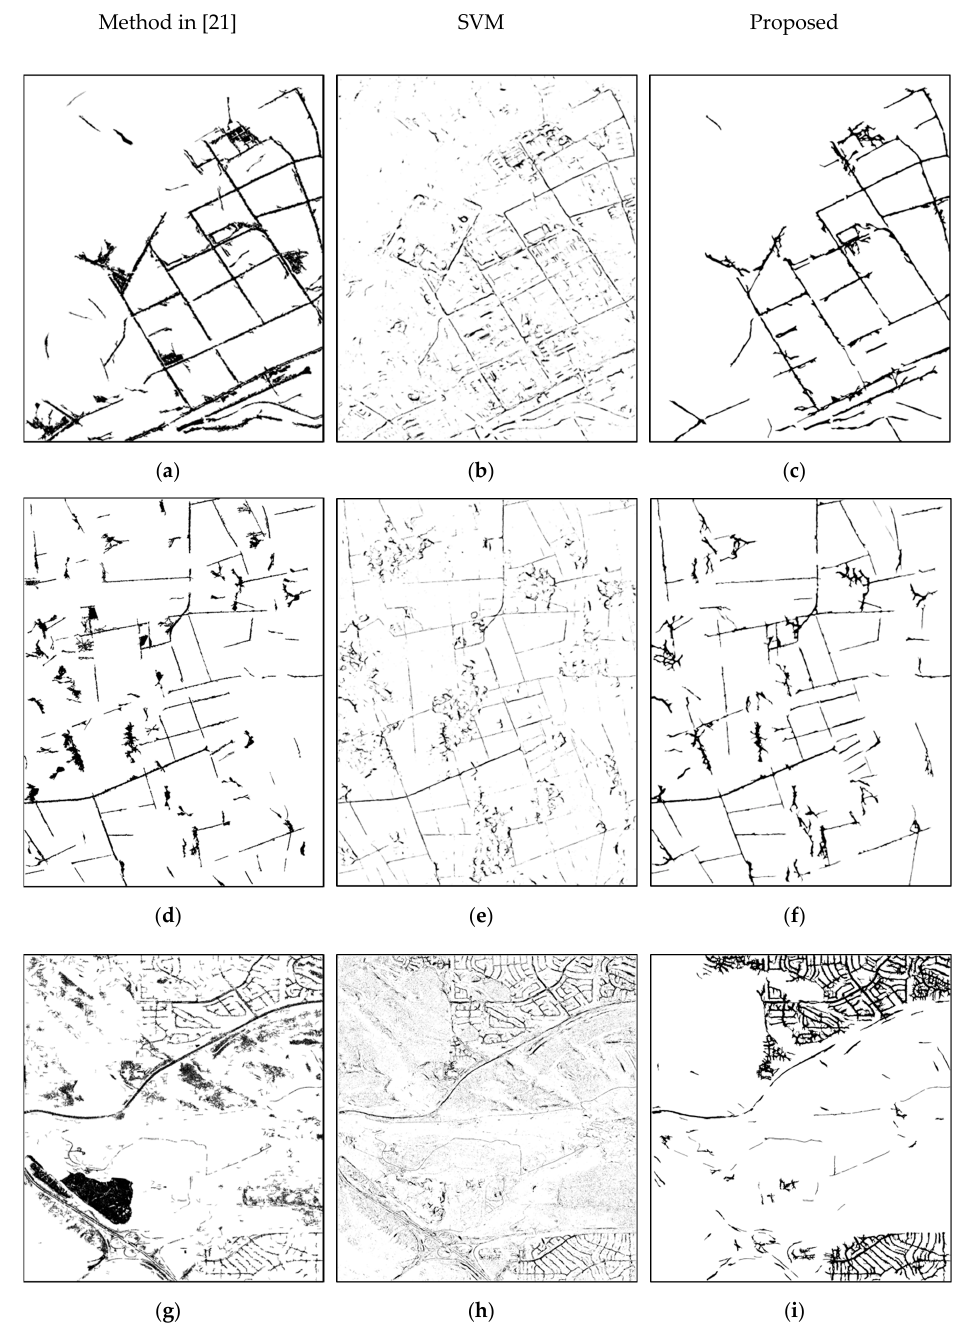
Figure 10. Segmentation results of road candidates using method in [21], SVM, and proposed approach: ( a–c ) study site 1; ( d–e ) study site 2; ( g–i ) study site